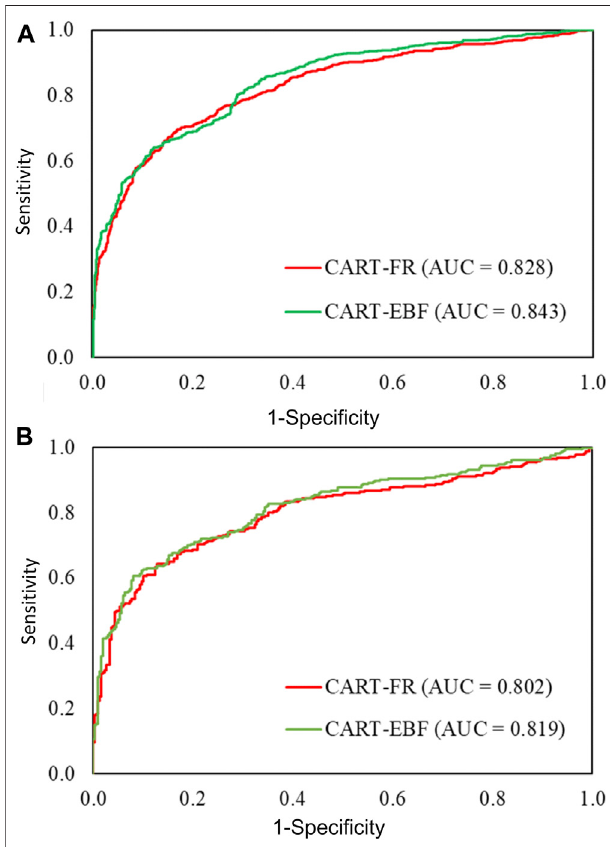
FIGURE 7 | Area under receiver operating characteristics (AUROC) curvefor the model was constructed in a single graph in order to compare the model ’ s performance. Validation of the models was performed using 30% of the randomly generated fl ood points speci fi cally segregated from the points kept for the purpose of validation using AUROC statistical method. Panel (A) is computed using training dataset (represents model success rate) and Panel (B) with validation datasets (shows model prediction rate).